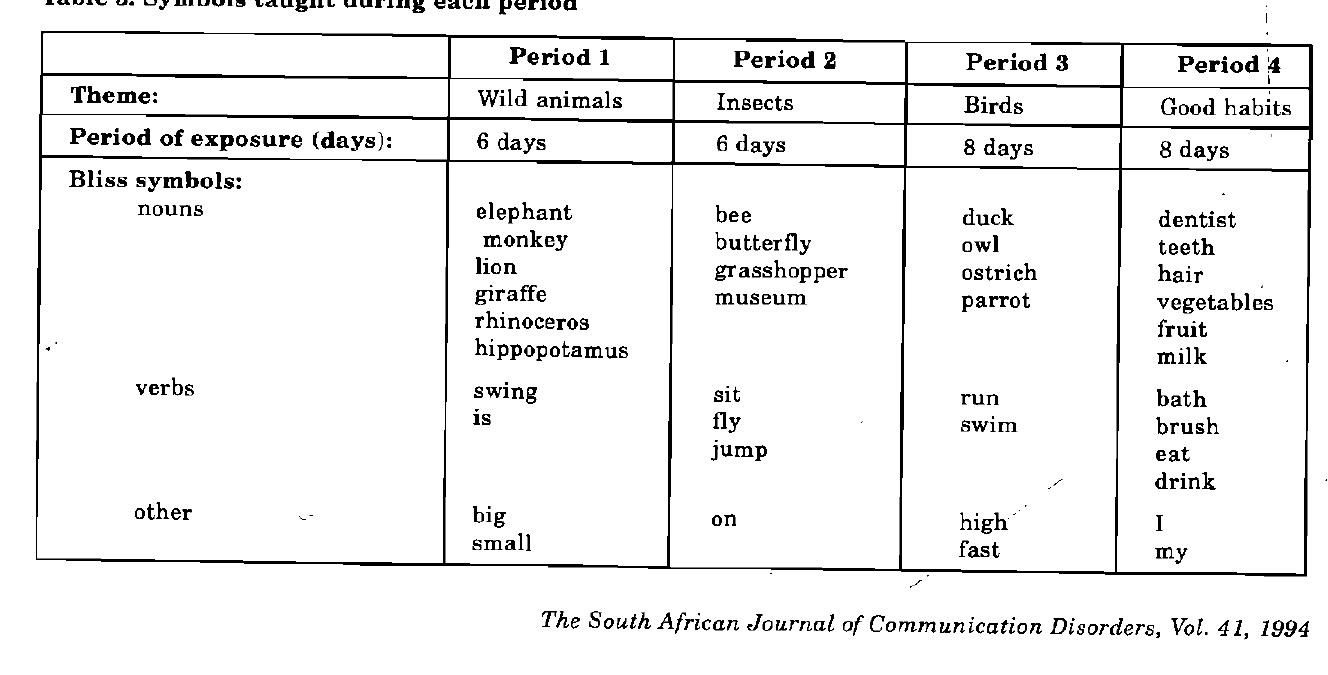
Table 3. Symbols taught during each